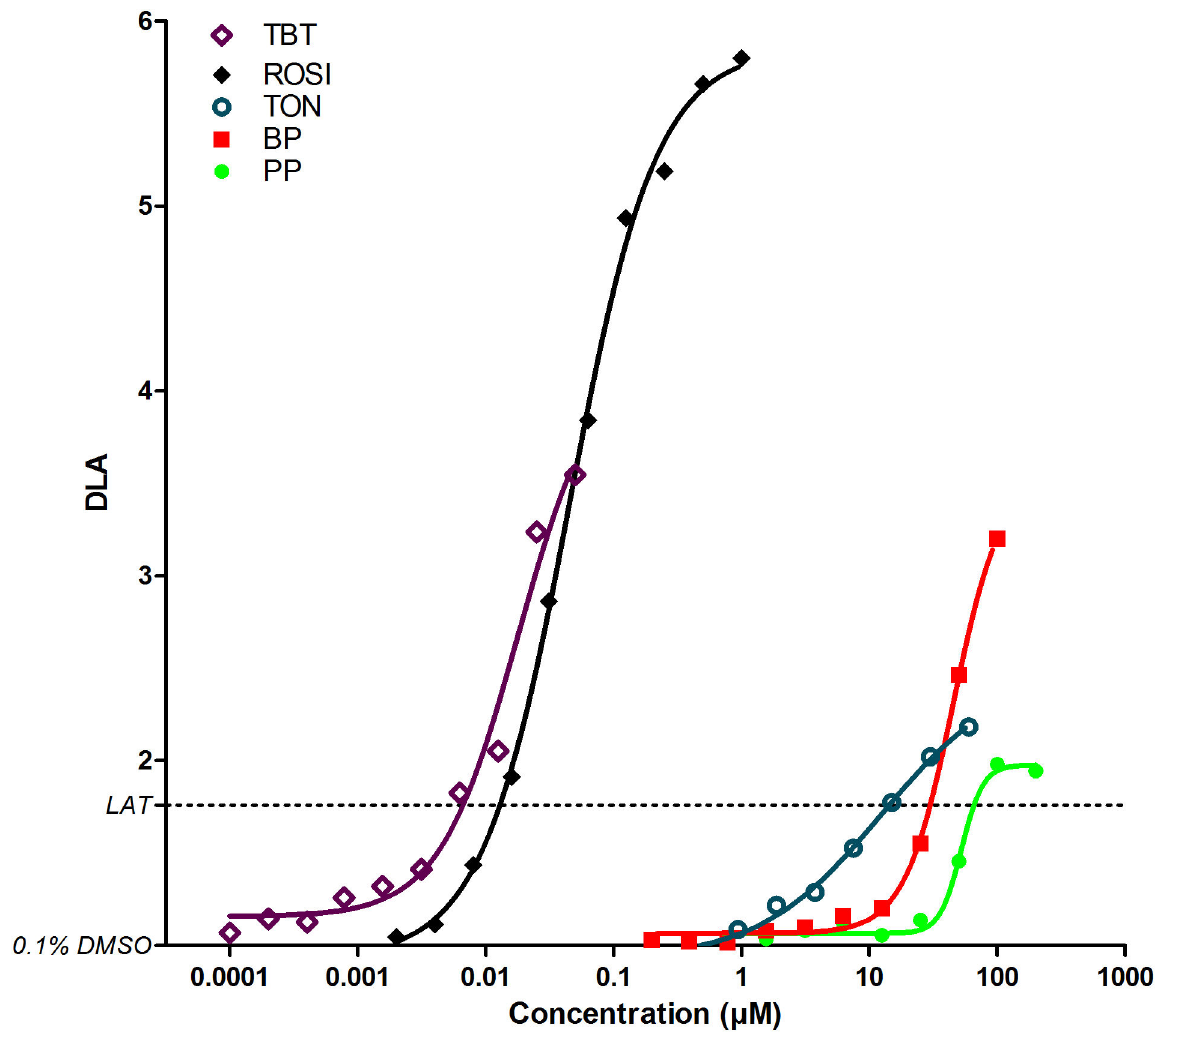
Figure 6. Dose-response relationships of strong obesogens based on adipocyte differentiation in 3T3-L1 cells. Data represent the same data as figure 2 and 3 but with 10 concentrations shown. Mean of the degree of lipid accumulation (DLA) of three independent experiments are shown. LAT: Lipid accumulation threshold